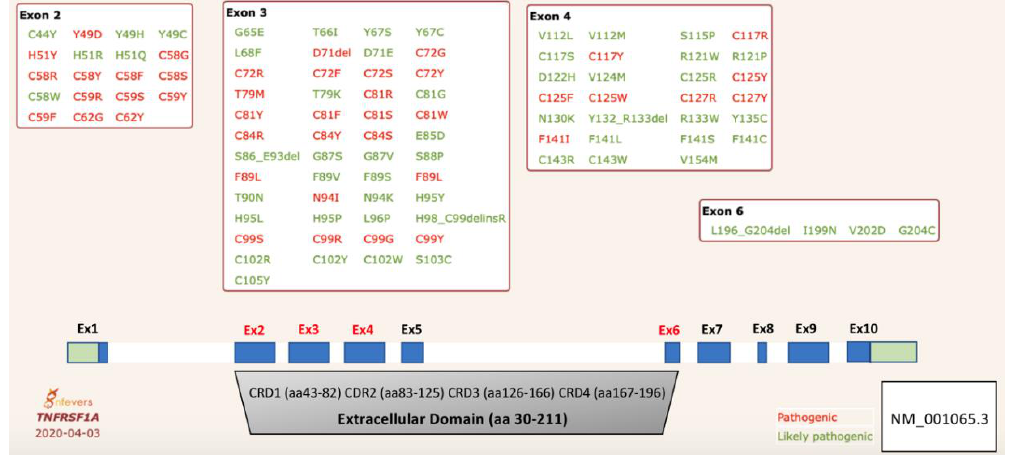
Figure 1. Schematic representation of variants in the TNFRSF1 gene associated with tumor necrosis factor receptor-associated periodic syndrome (TRAPS). Pathogenic variants are found predominately in the first two cysteine-rich domains, CRD1 and CRD2. The numbering system for TNFR1 (tumor necrosis factor receptor 1) begins at amino acid residue methionine 1. The CRD domains are defined based on the UniProtKB database [9].